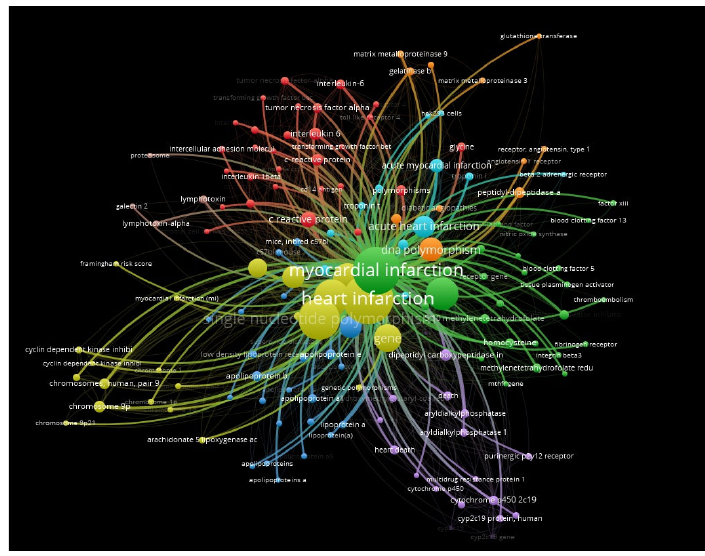
Figure A2. SCOPUS map and network.